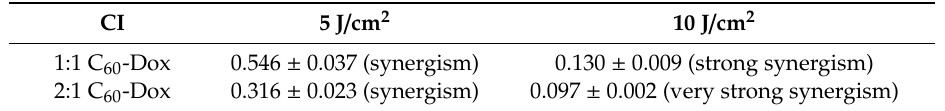
Table 2. Combination index of interaction between phototoxic e ff ects of C 60 (PDT) and non-irradiated C 60 -Dox nanocomplexes (improved CT) 1